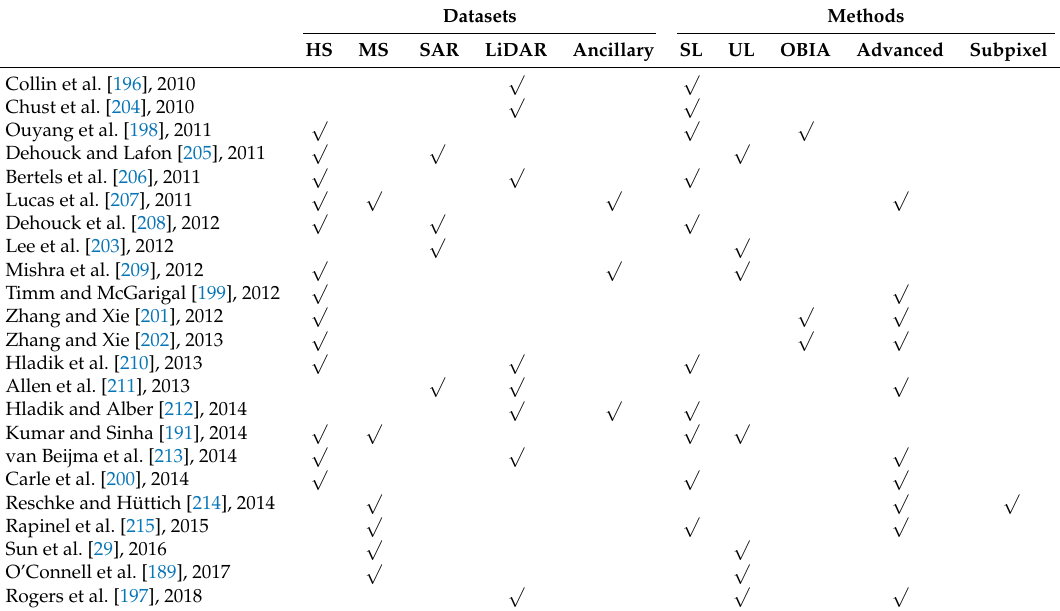
Table 6. Salt marsh mapping techniques using remotely sensed data from